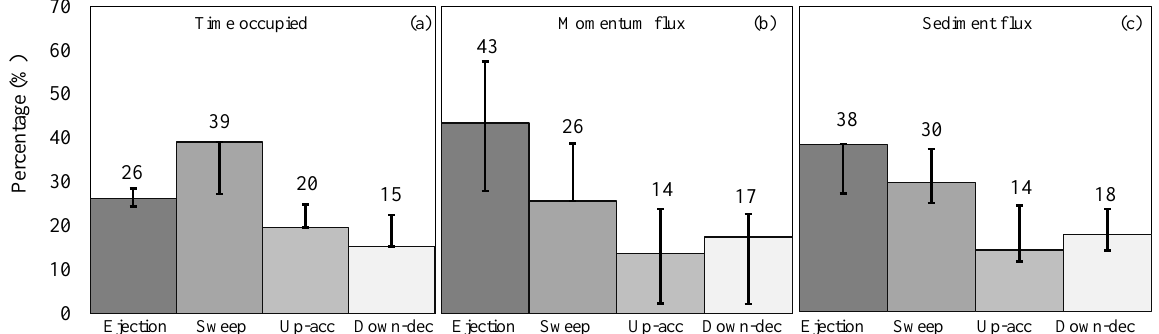
Figure 8. Quadrant analysis of coherent structures in below the measured mean critical velocity range ( u < u cr,measured ) showing the (a) time occupied, (b) momentum flux ( u (cid:48) ,w (cid:48) ), and (c) sediment flux ( c (cid:48) ,w (cid:48) ). The error bar represents the maximum and minimum values of the total